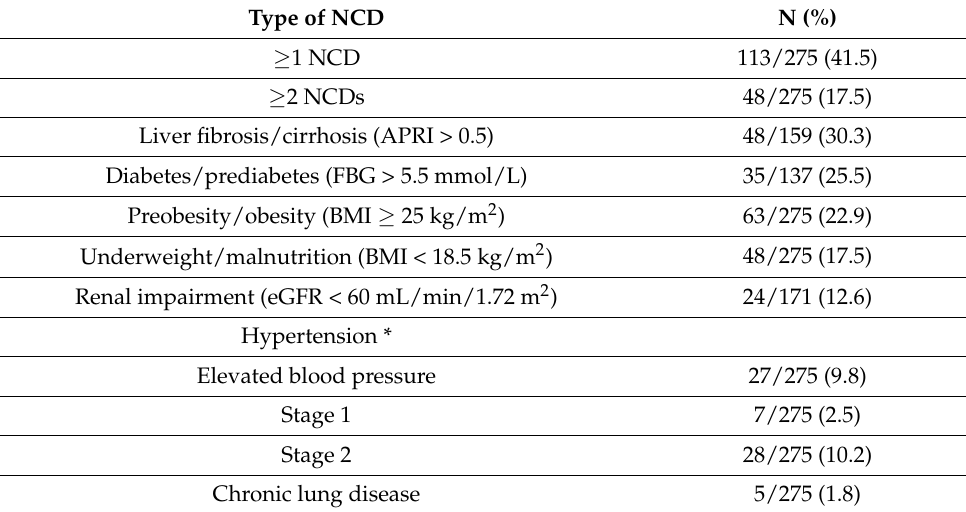
Table 3. Prevalence of NCDs by